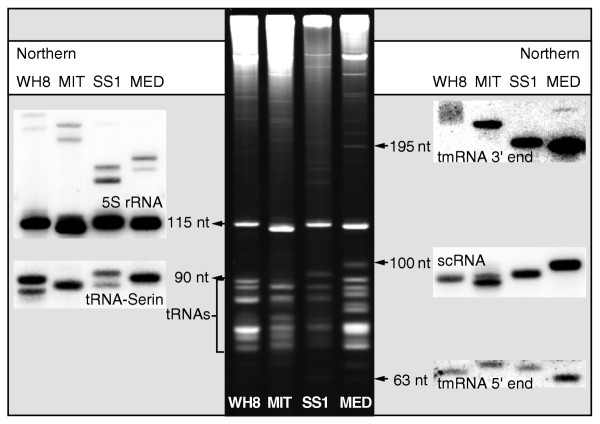
Small RNAs in marine Cyanobacteria. About 10 μg of total RNA from Prochlorococcus strains MIT 9313 (MIT), SS120 (SS1) and MED4 (MED) and from Synechococcus sp. WH 8102 (WH8) was analyzed by staining a 10% polyacrylamide gel with ethidium bromide (center) and by Northern blot hybridization with DNA-oligonucleotides directed against known RNA molecules such as scRNA (ffs gene product), the separate 5' and 3' ends of tmRNA and, as controls, tRNASerin and 5S rRNA. Two distinct precursors of the 5S rRNA were detected. Selected bands have been labeled by arrows in the hybridization and in the gel picture and their sizes (nt, nucleotides) are indicated.